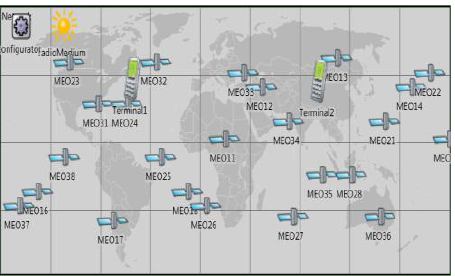
Figure 1. 2D view of the Space-Ground